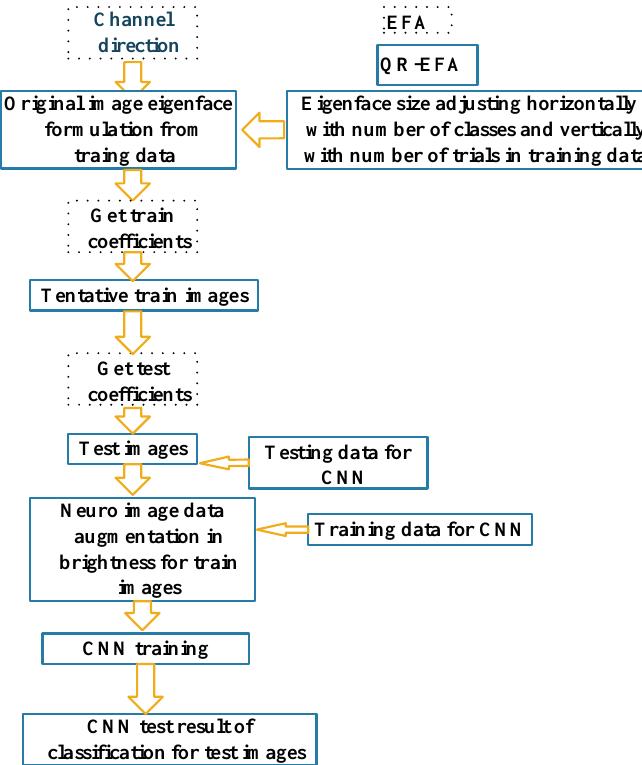
Figure 5. Overall flowchart for QR-EFA (solid line) including EFA (dashed line). Cross reference in the above data flowchart for step 1~11.